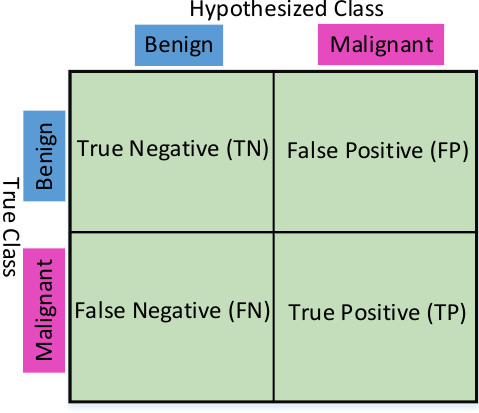
Figure 9. Confusion